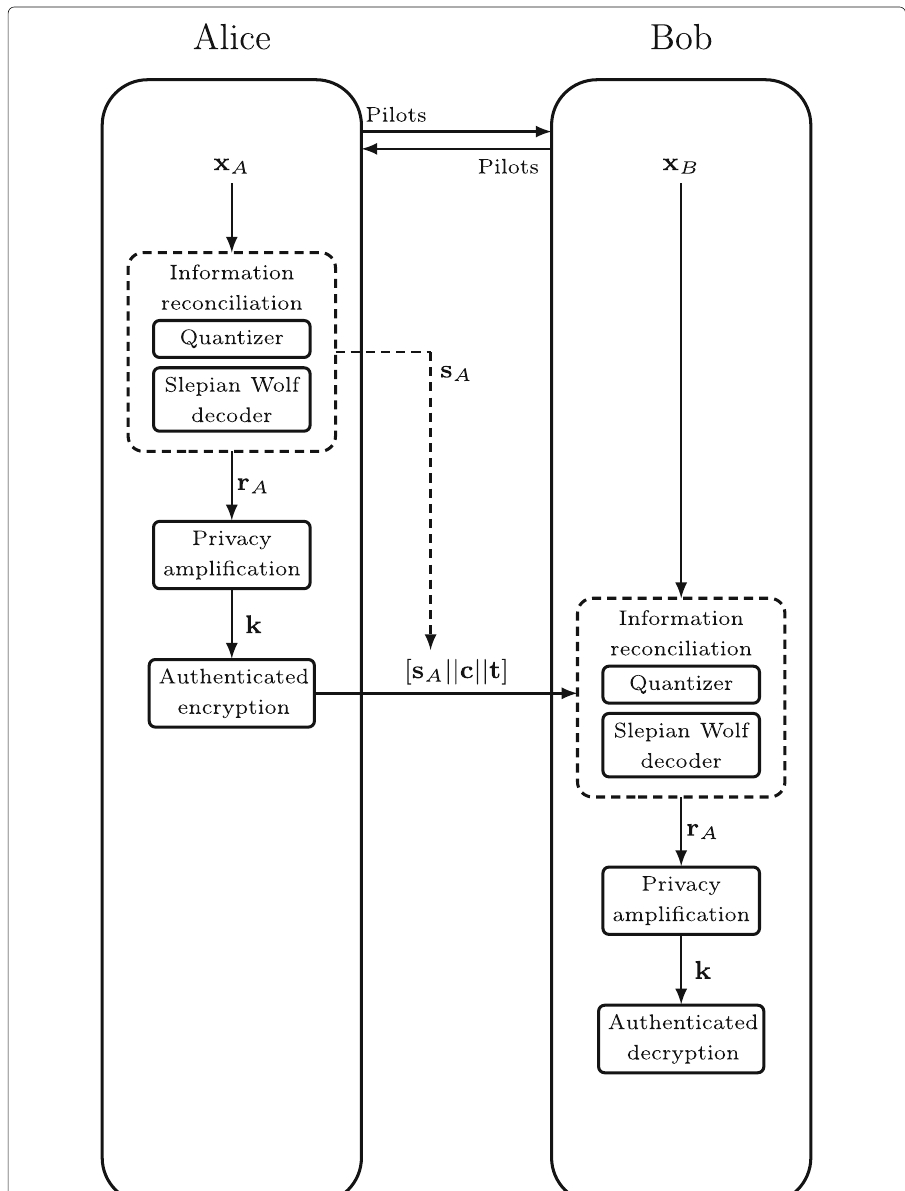
Fig. 3 Pipelined SKG and encrypted data transfer between Alice and Bob